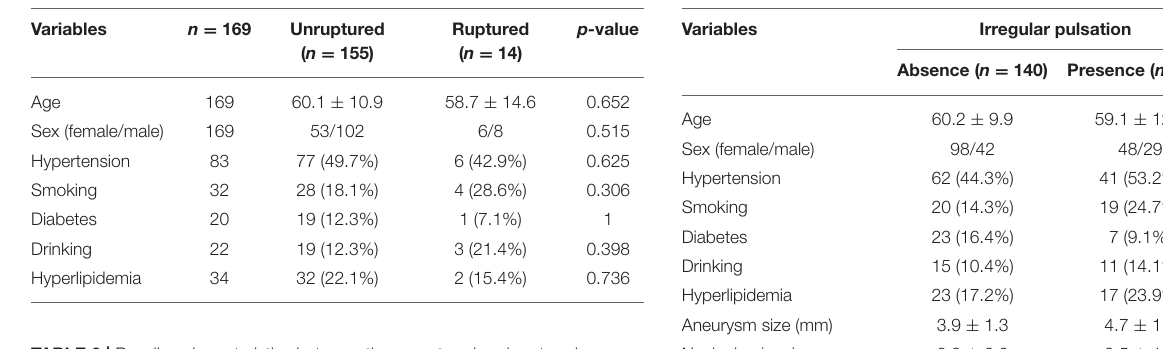
TABLE 2 | Baseline characteristics between the unruptured and ruptured aneurysm groups. Variables